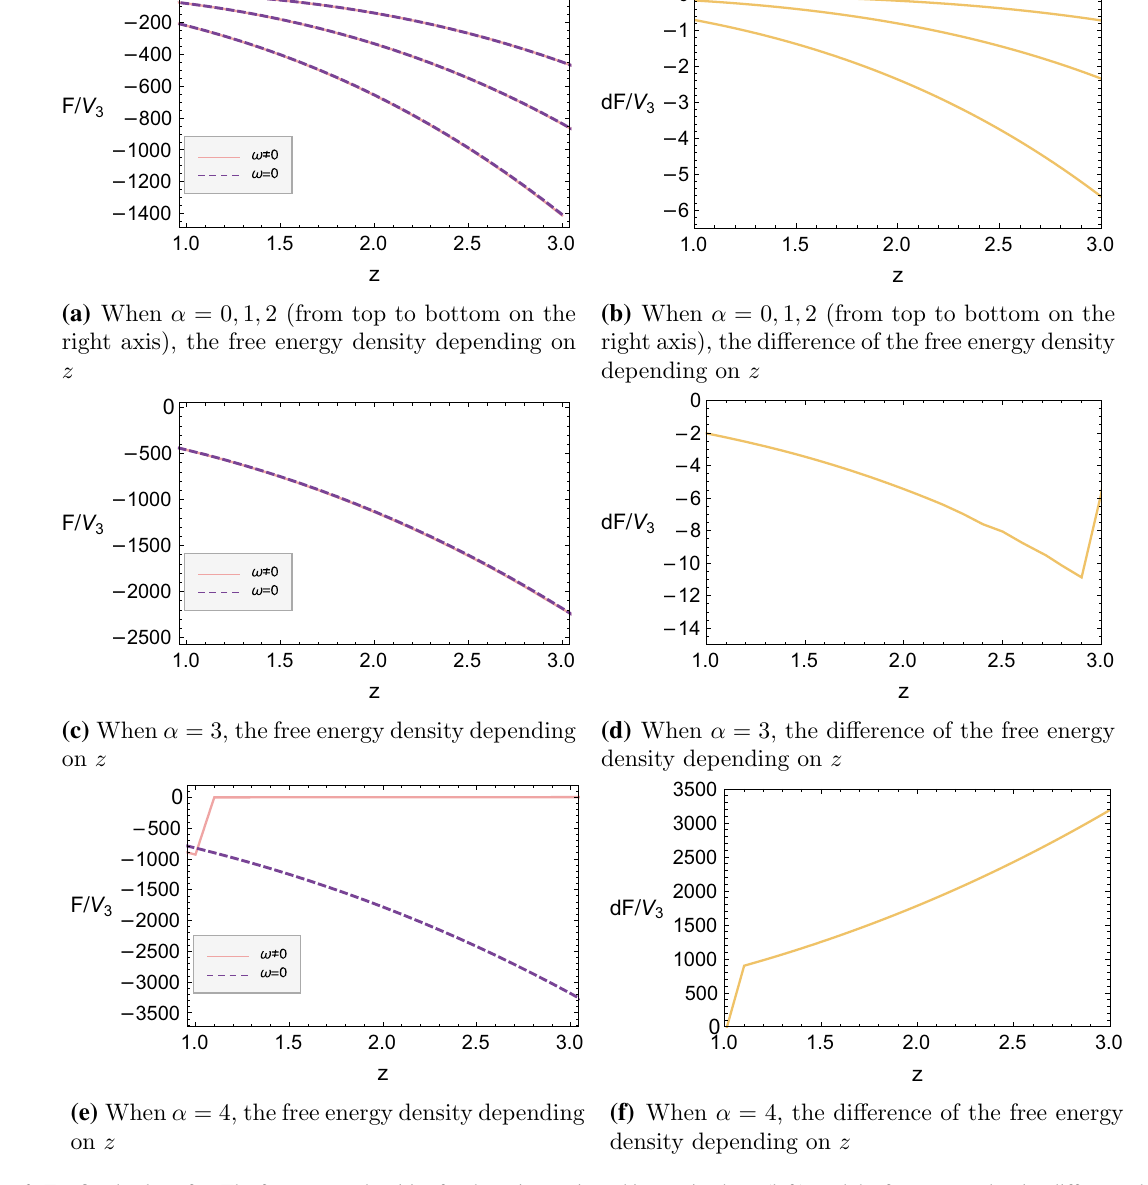
Fig. 5a, c, e. The red solid and the blue dashed lines indi- cate the anisotropic and isotropic phase, respectively. Their differences are shown in Fig. 5b, d, f in more